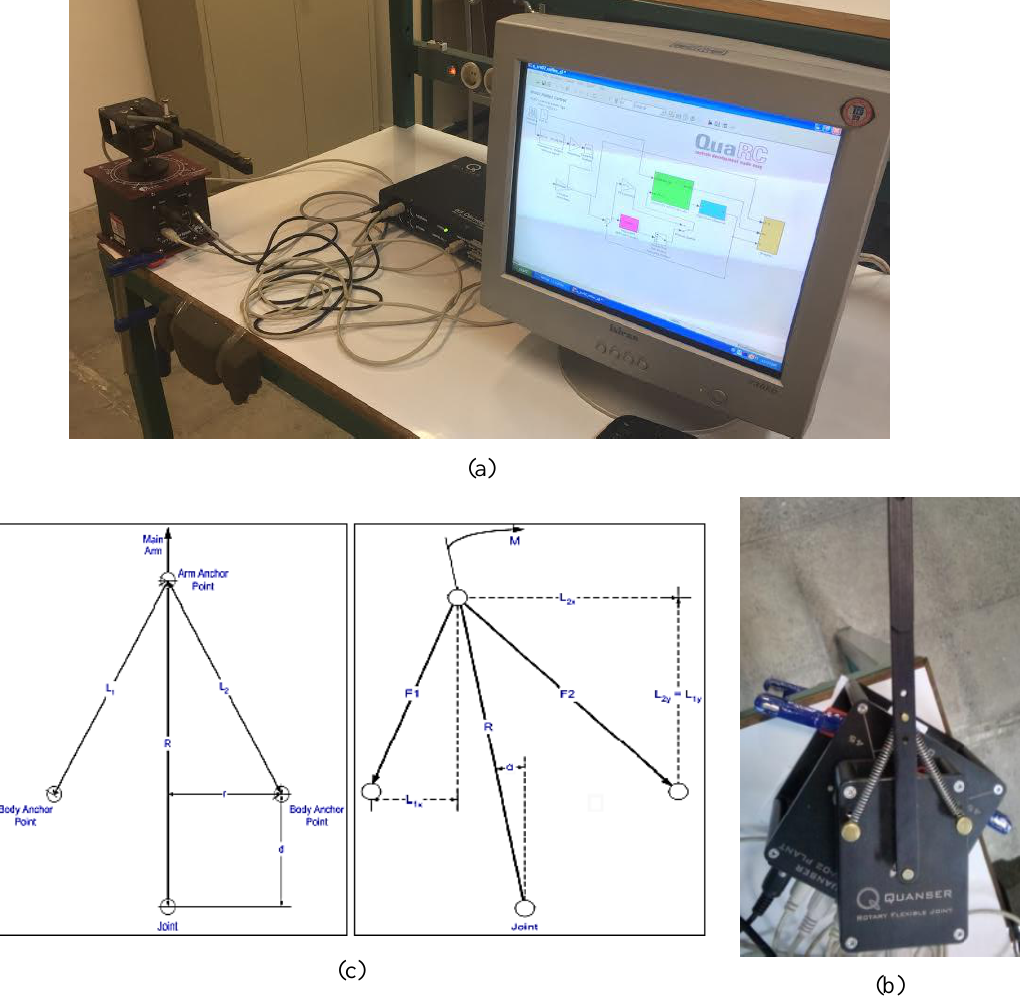
Figure 1. (a) Overview of the experimental setup, (b) the flexible joint and, (c) its